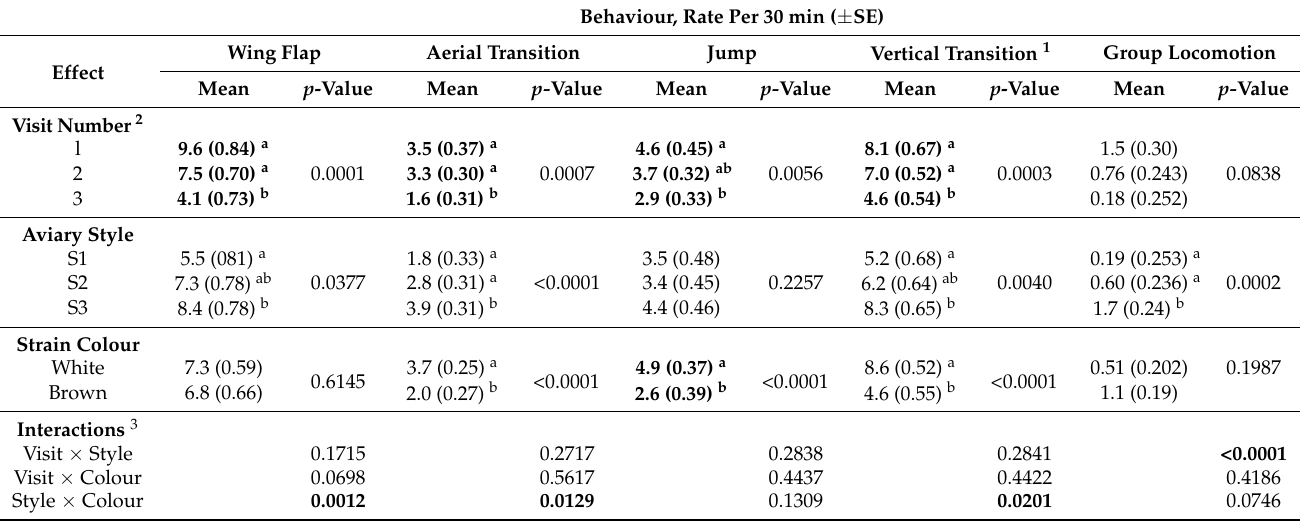
Table 5. Least square means ( ± standard error) of the rate per 30 min of wing-associated behaviours performed by brown- and white-feathered strains of layer pullets housed in three different styles of commercial rearing aviary systems of increasing structural complexity throughout the rearing